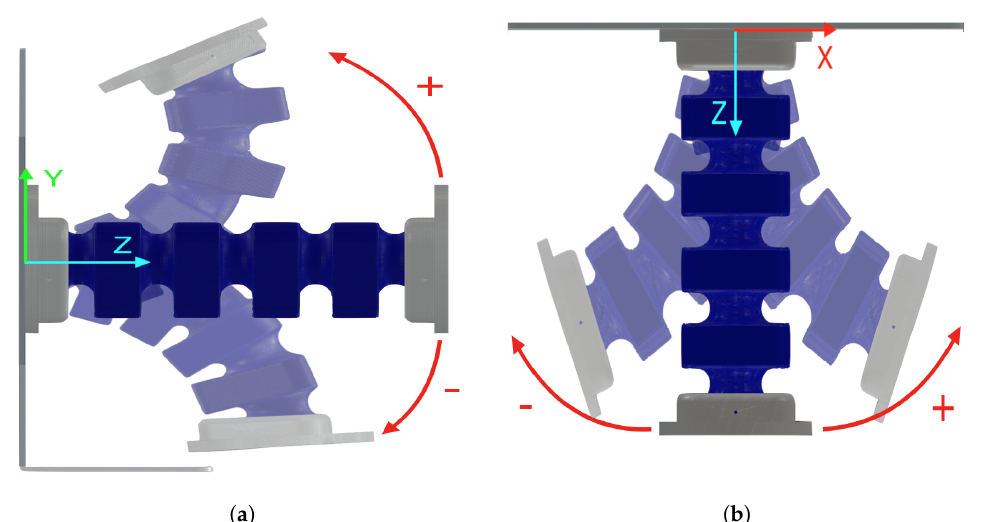
Figure 4. The panels show the flexion of the soft robotic arm ( a ) from a lateral view in positive and negative pitch flexion and ( b ) from a top view in positive and negative yaw flexion. For a negative pitch bending, panel ( a ) shows how the vertices will touch, preventing further bending in that direction. For a positive pitch flexion, the edges need more bending for this contact to occur. The yaw flexion in panel ( b ) has symmetry in the positive and negative directions. The combination of pitch and yaw rotations allows movements with two degrees of freedom, and the limits of flexion vary according to the combined